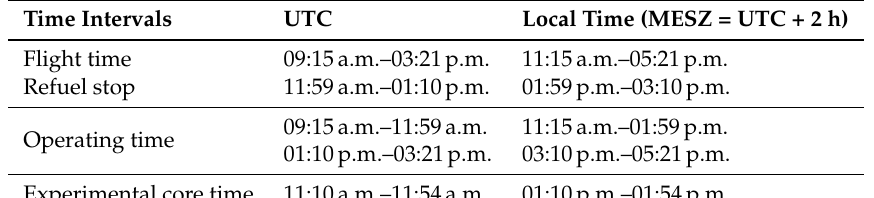
Table 2. Overview of the timing of the different phases of the experimental flight.